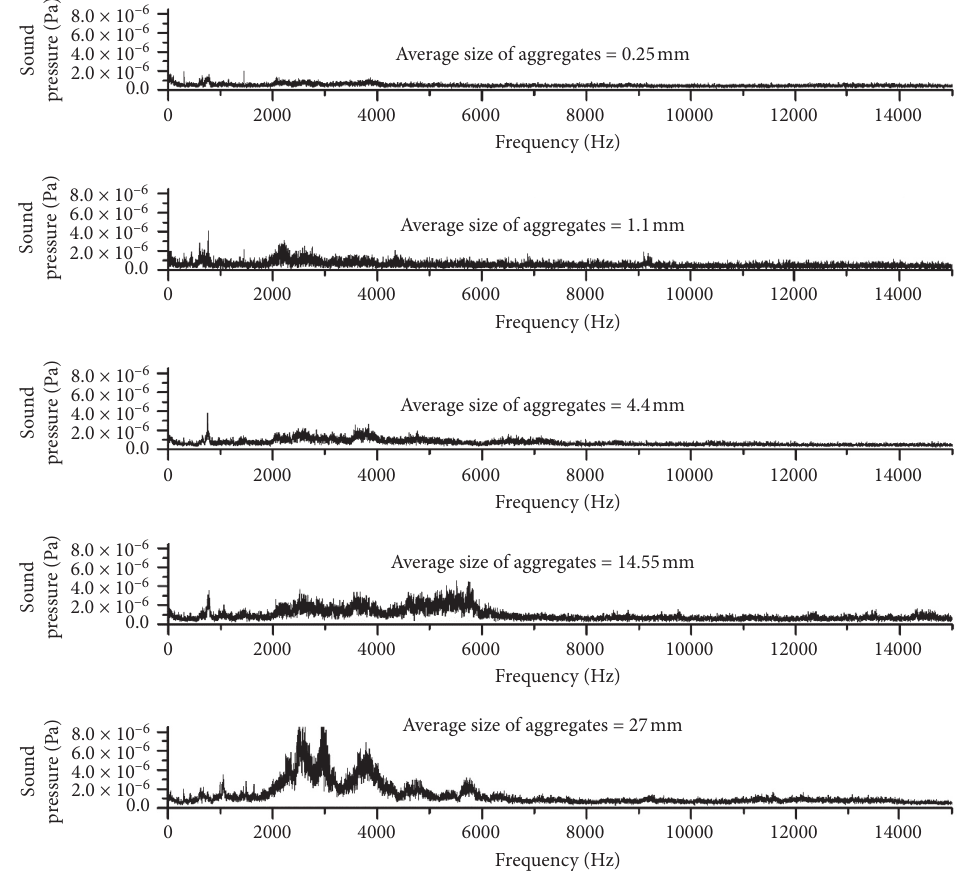
Figure 7: Frequency-domain analysis for the drilling sound signals of several specimens.